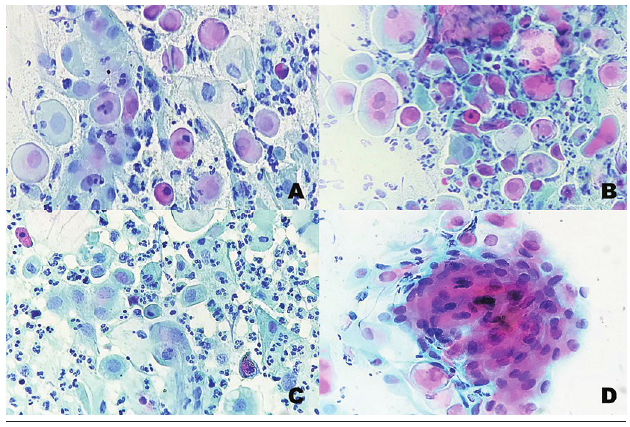
FigurE 4 − Atrophy associated with inflammation A) parabasal squamous epithelial cells in a cell debris background; B) immature cells with benign reactive changes: nuclear pyknosis, pseudo-eosinophilia and polychromasia; C) predominance of parabasal squamous epithelial cells intermingled with leukocyte infiltrate; D) grouping of parabasal squamous epithelial cells (magnification